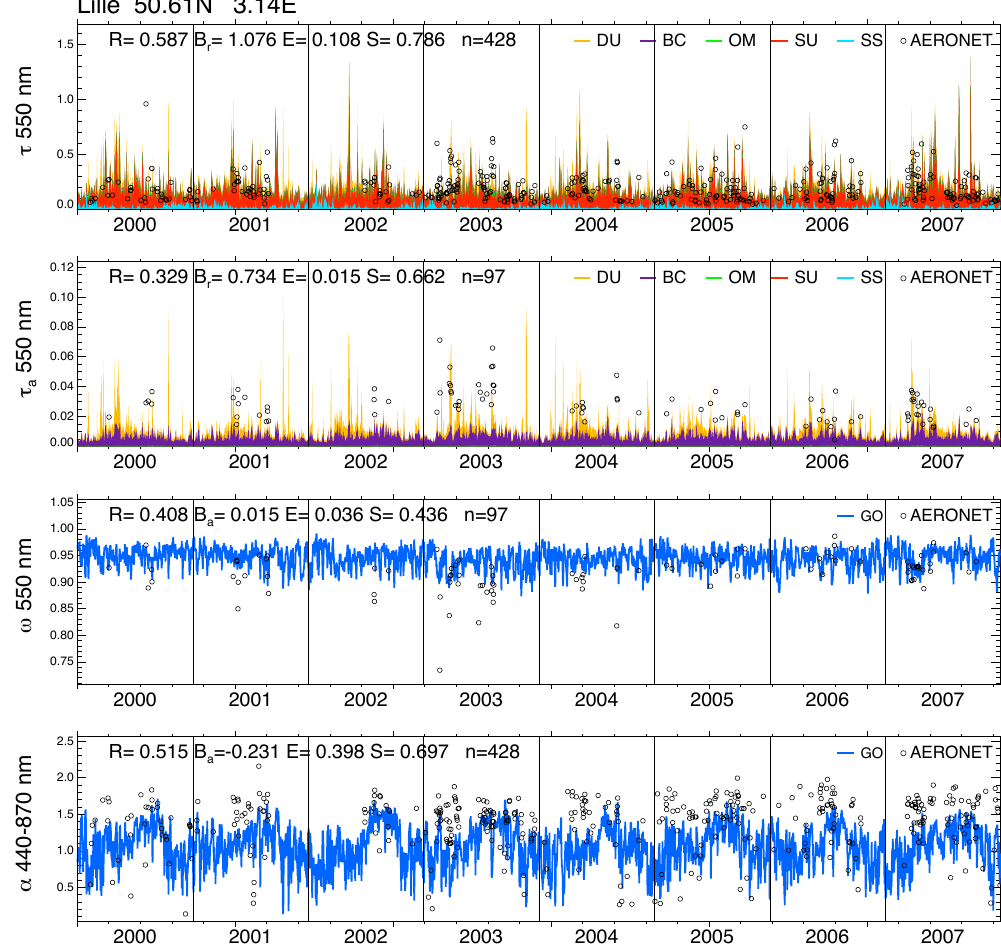
Fig. 5b. Same as Fig. 5a but for Lille, France.